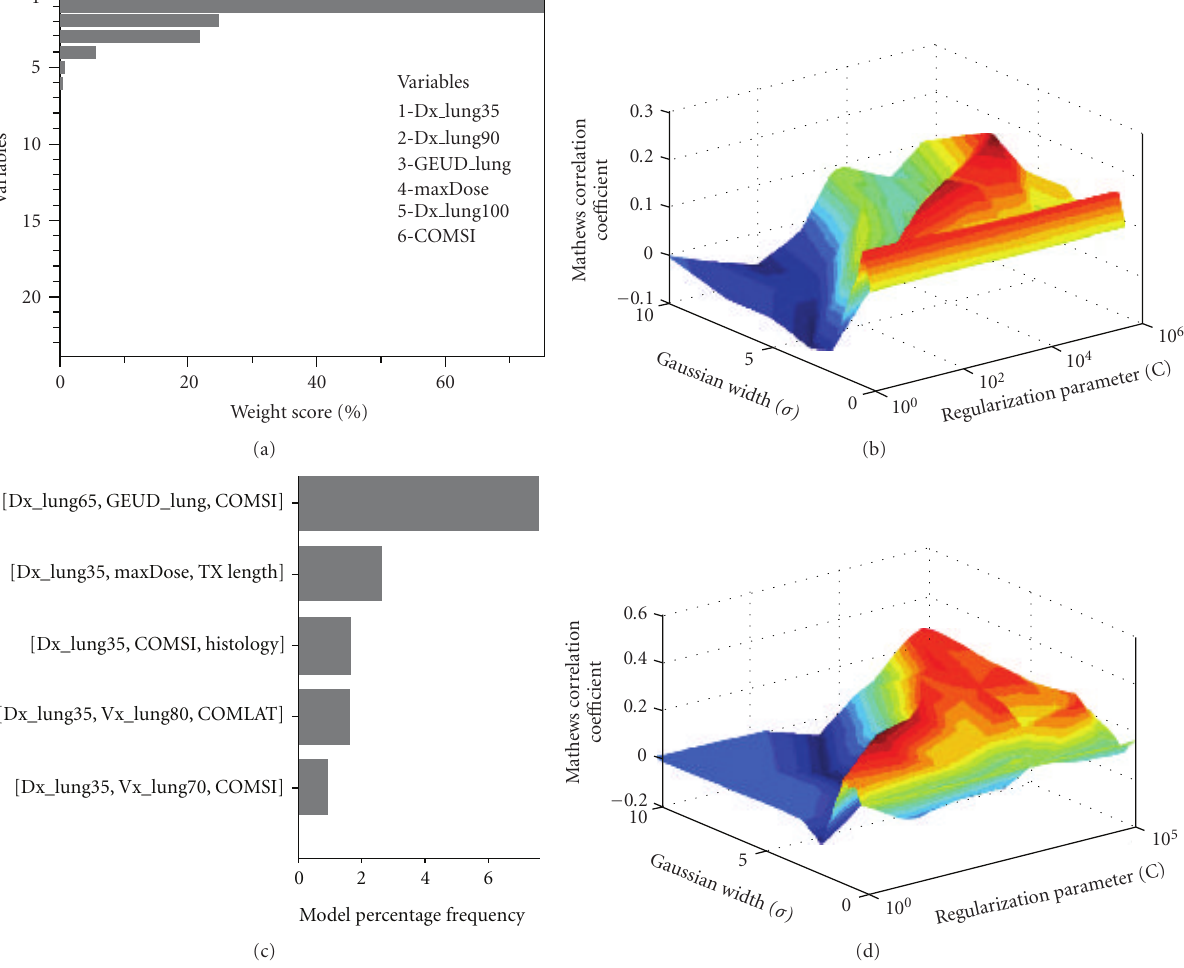
Figure 9: RP with a premodeling variable selection using (a), (b) the recursive feature elimination (RFE) method. Variables were chosen from a pool of 58 dosimetric, positional, and clinical variables. The top 23 variables selected by SVM-RFE are shown after applying a pruning step to correct for multicollinearity (RS = 0 . 75)(RS = 0 . 75). The top 6 variables (by applying a cuto ff of 5% weighting score) were used for modeling pneumonitis. (b) An SVM-RBF classifier was tested on LOO data. (c), (d) Multimetric logistic regression approach. (c) The frequency of selected models order of 3 using our two-step resampling methods. The best-selected model consisted of three parameters (D35, COM-SI, and maximum dose). (d) The results of applying the SVM methodology with RBF kernels using these selected variables on LOO testing data. Note the improved performance in this case compared to RFE variable